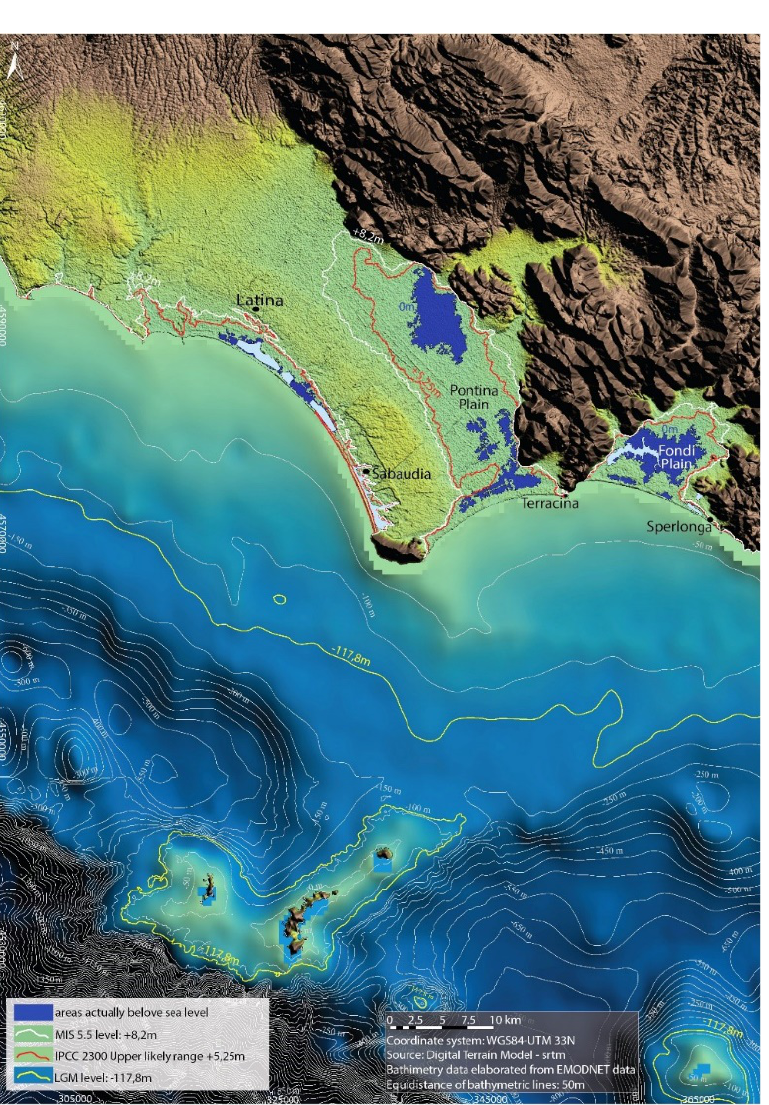
Figure 15. The Pontina and Fondi Plains maps showing the potential submersion area using IPCC AR5 RCP 8.5 for 2100 and 2300: the MIS 5.5 extension occurred 119 ka BP.